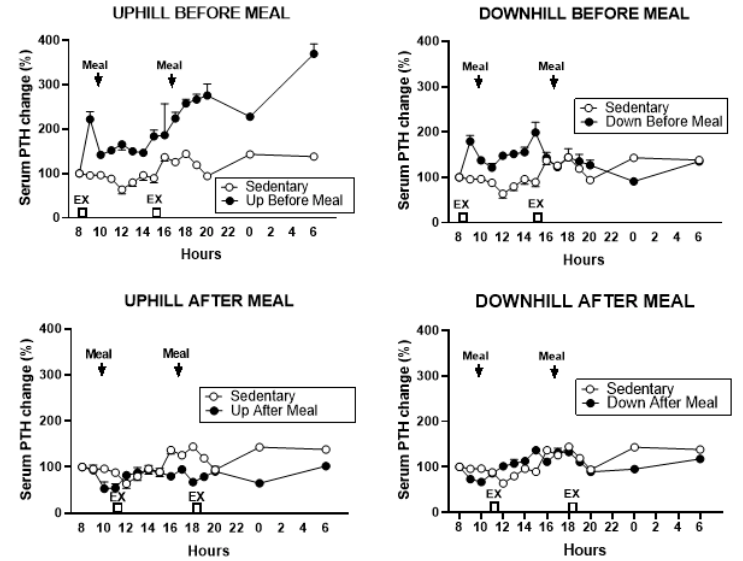
Figure 11. Percent changes in serum parathyroid hormone (PTH) between sedentary trial and exercise trials performed before meals is shown at the top (left: UBM, right: DBM), and after exercise trials performed after eating, is shown at the bottom (left: UAM, right: DAM). PTH response was higher after both exercise trials performed before eating than during the sedentary trial and did not change during two exercise-after-meal trials.